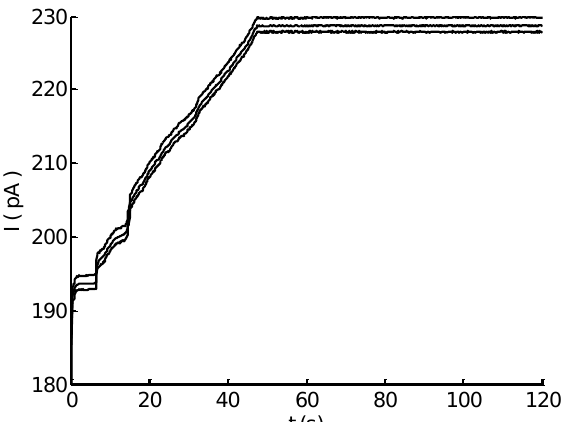
Figure 5. Time evolution of electrode current after introducing a drop of NaCl solution into the inlet cavity.